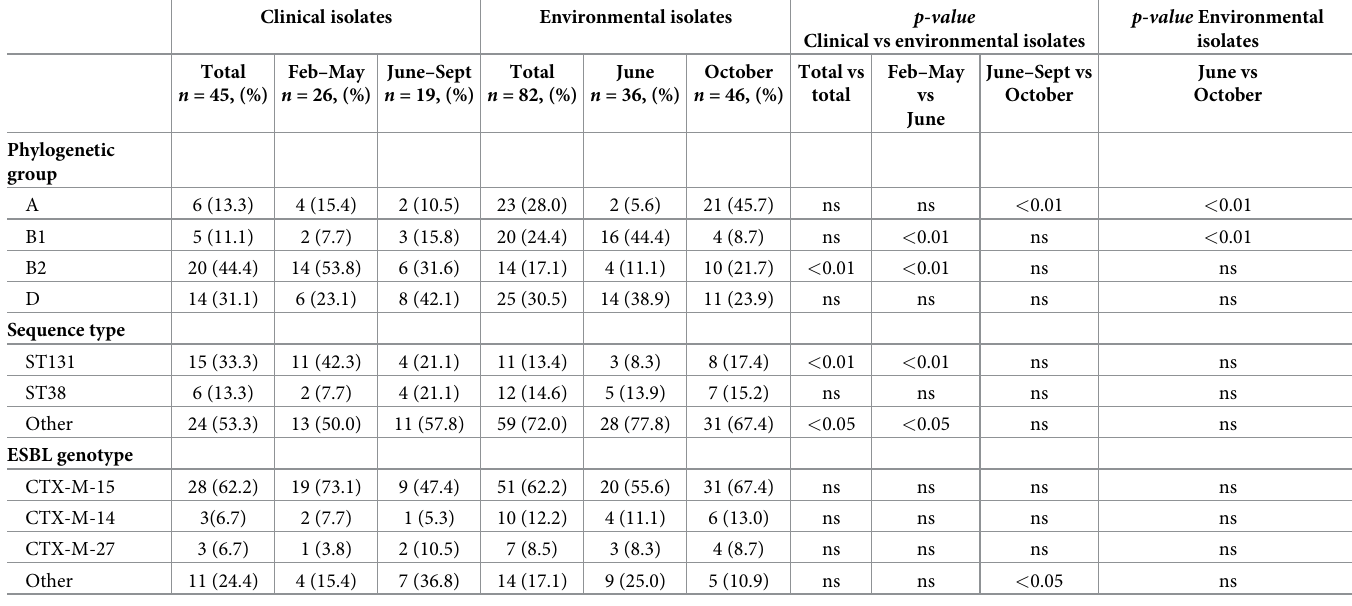
Table 1. Distribution of phylogenetic group, sequence type (ST), and ESBL genotype in clinical isolates and isolates from water